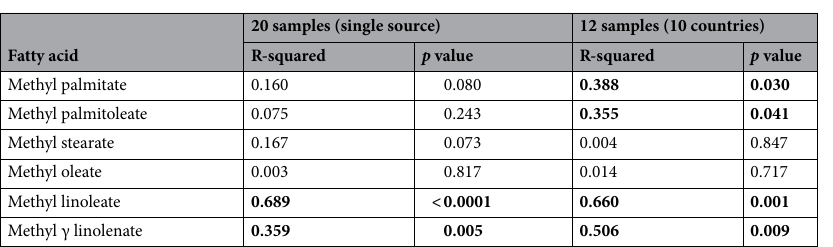
Table 4. Linear regressions between TLR2/TLR1 extract activity and content of individual fatty acids in biomass obtained from Dongtai Cibainian Biological Engineering (20 samples, details in Supplementary Table S2 online) and commercial growers in 10 different countries (12 samples, details summarized in Table 1 and Supplementary Table S3 online). Bold values indicate regressions that are statistically significant.